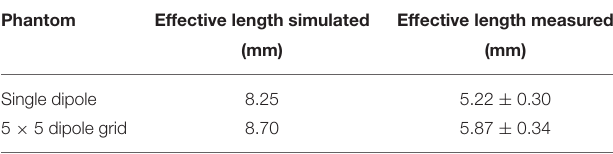
TABLE 3 | Simulated and measured effective dipole lengths of the two phantoms. Phantom Effective length simulated Effective length measured (mm) (mm) Single dipole 8.25 5.22 ±